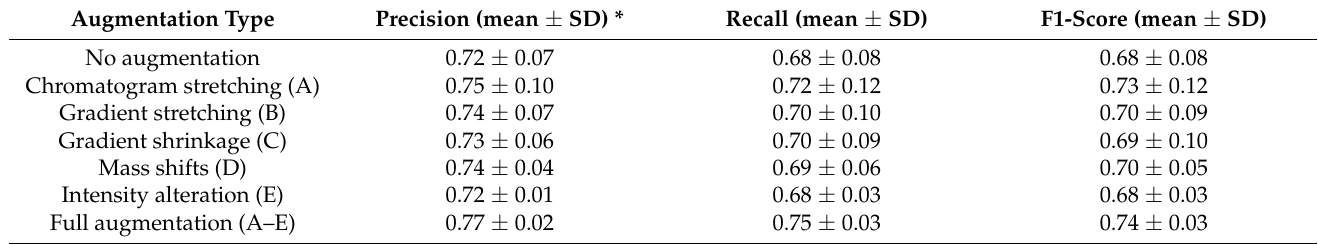
Table 3. Results of the Apiaceae plant part classification by SVM after data